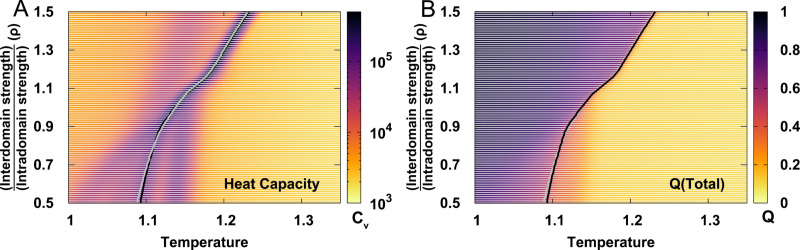
Extracting folding temperature Tfρ from the heat capacity curves and melting curves of Q(Total) for different values of ρ.Tf can be determined as the position of the prominent peak on heat capacity curve (black lines) or the midpoint of melting curves of Q⁢(Total) (grey lines).These two methods generate very similar Tf, so Tf from heat capacity was finally chosen.